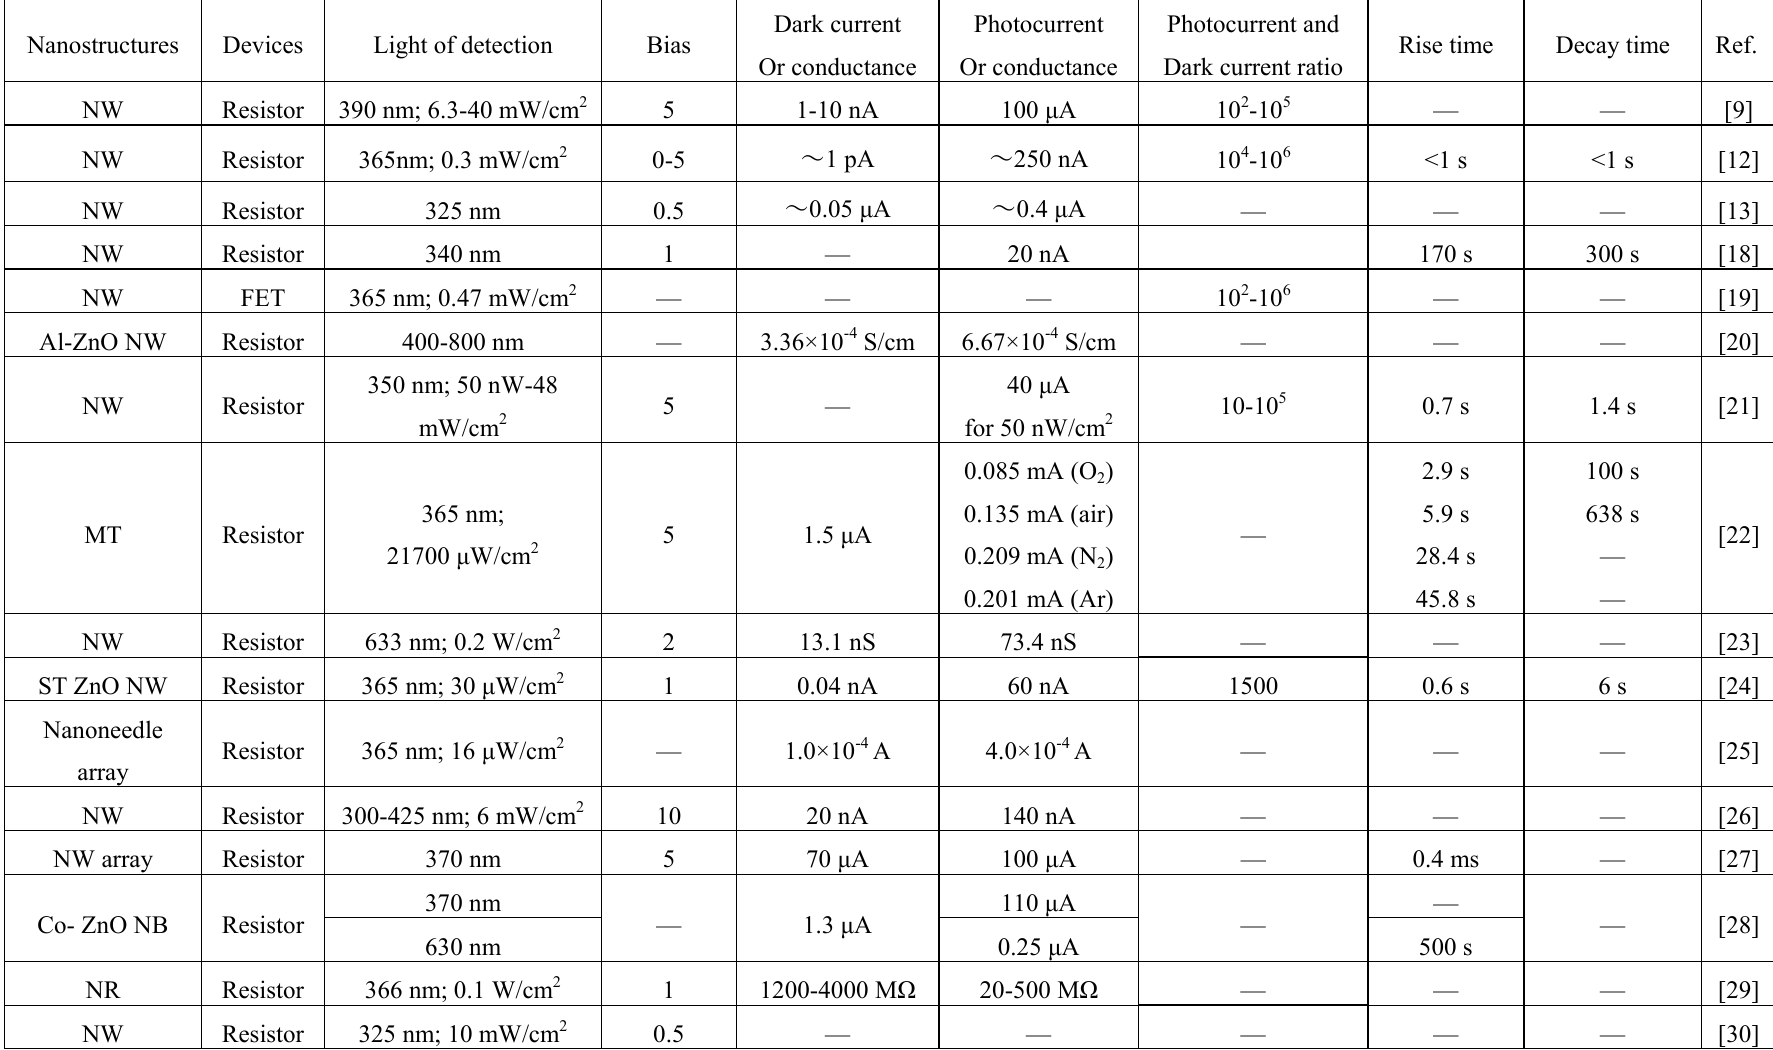
Table 2. ZnO-based